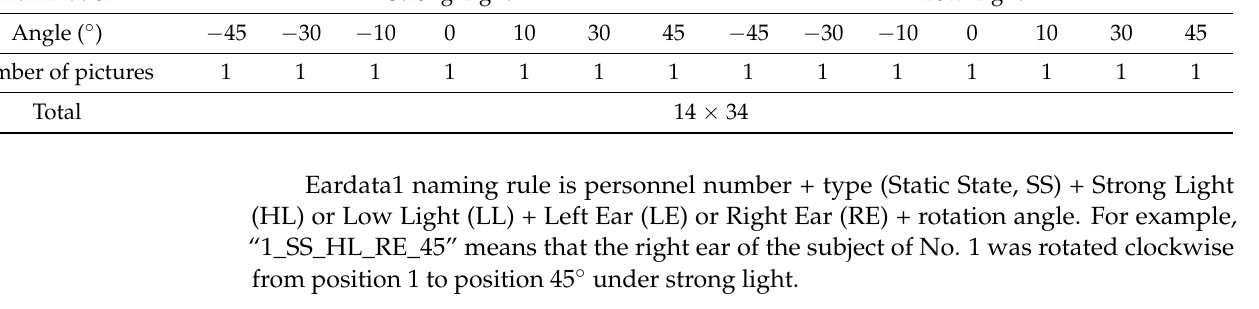
Table 4. Human ear database information of Eardata1-right.